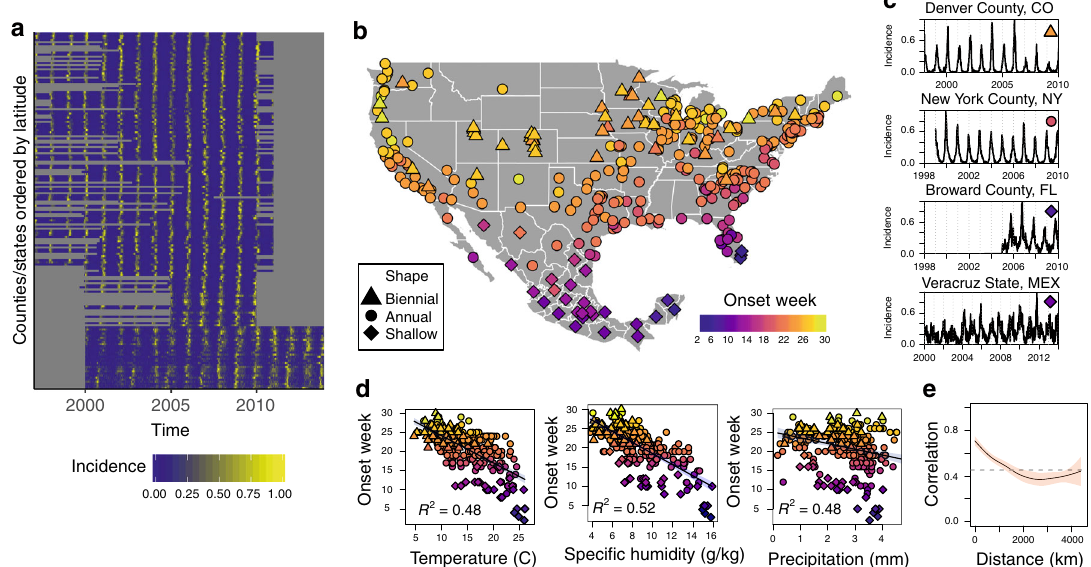
Fig. 1 Broad-scale patterns of RSV are correlated with local climate. a Incidence time series for each county (USA) and state (Mexico) in the dataset. b Timing of onset (color) and dynamic pattern (shape) of each location in the dataset. c Example incidence time series for four location exhibiting distinct dynamic patterns. d Correlation between timing of epidemic onset and mean climate conditions (averages over temporal range of data). e Spatial correlation between RSV time series.